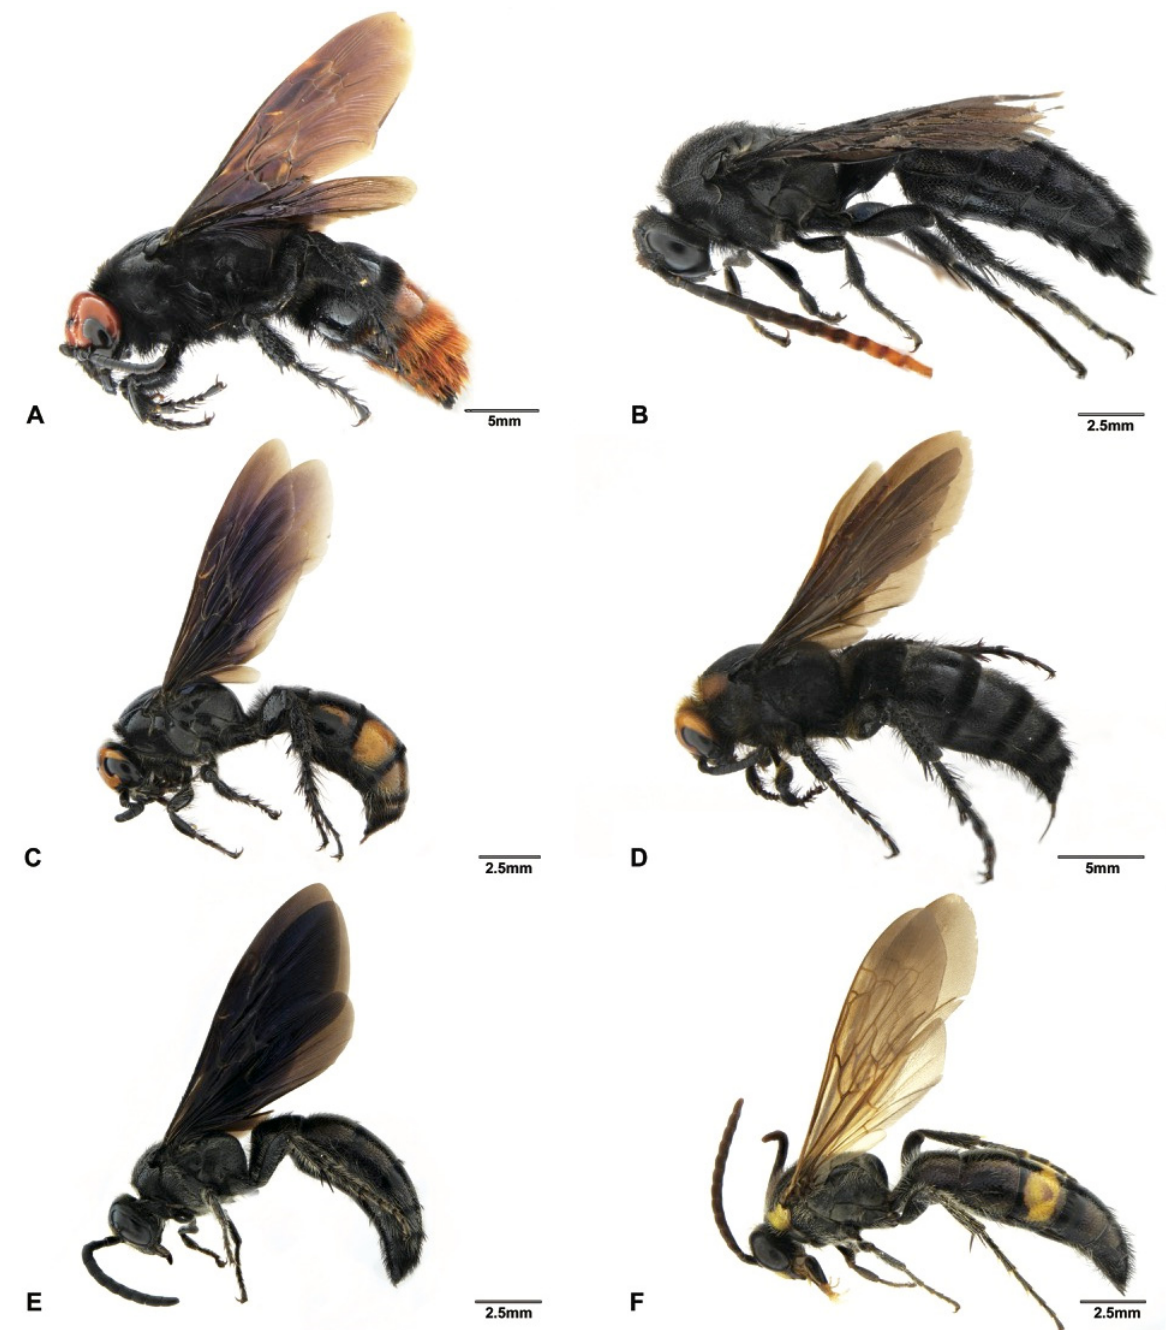
Figure 3. Habitus, lateral view. ( A ). Megascolia azurea (Christ, 1791), female (SCAU3043665); ( B ). Scolia affinis Guérin-Méneville, 1845, male (SCAU3043683); ( C ). Scolia binotata Betrem, 1928, female (SCAU3043684); ( D ). Scolia clypeata Sickman, 1894, female (SCAU3043682); ( E ). Scolia laeviceps Smith, 1855, male (SCAU3043680); ( F ). Scolia ( Discolia ) nobilis Saussure, 1858, male (SCAU3043681).